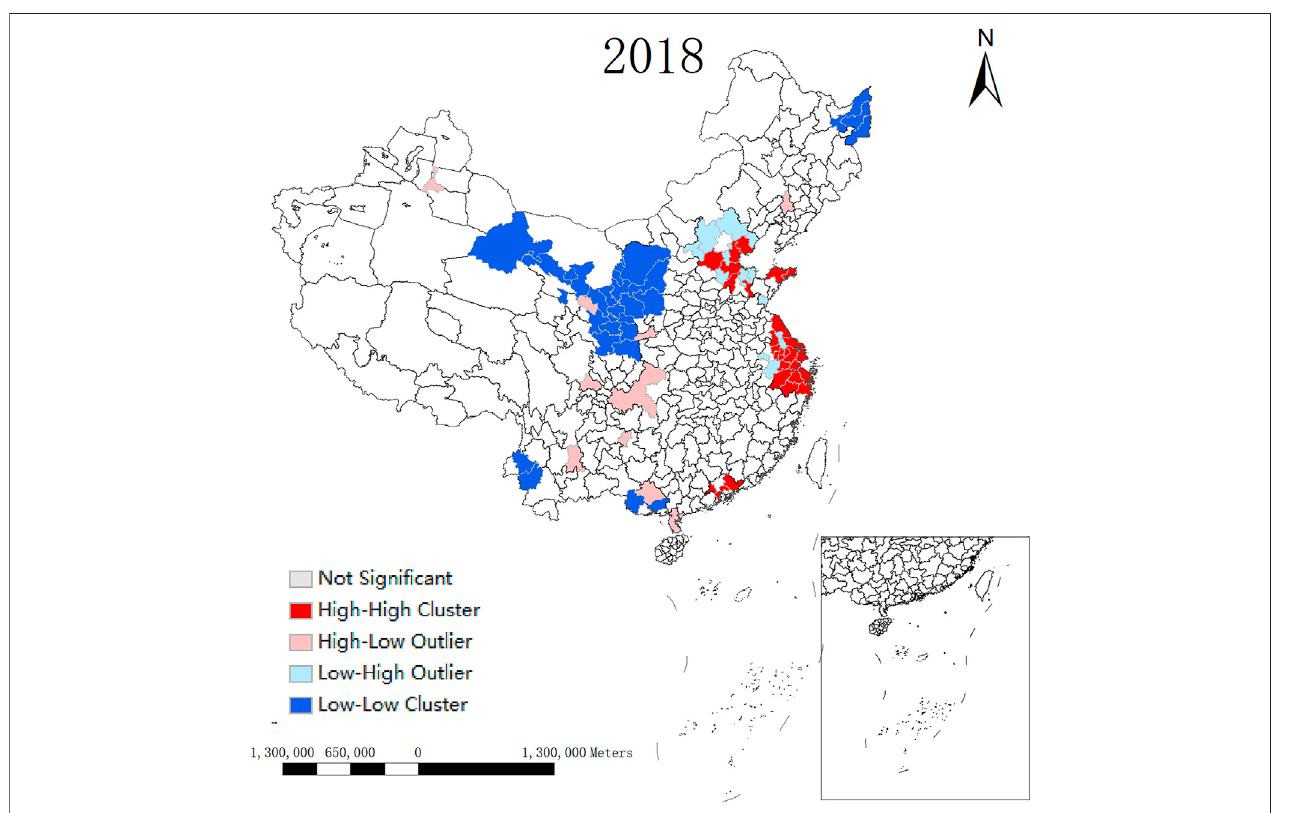
FIGURE 5 | Spatial correlation distribution of urban consumption in